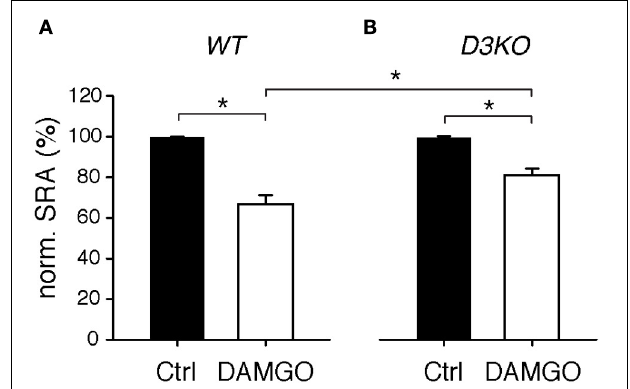
FIGURE 4 | Modulation of spinal reflex amplitudes (SRAs) by the MOR-preferring agonist, DAMGO. (A) In WT, DAMGO induced a significant decrease in SRA (to 66.6 ± 4.5% of control, n = 15). WT: ∗ p < 0 . 001. (B) In D3KO, DAMGO equally significant reduced SRA, albeit to lesser degree than in WT (to 80.9 ± 3.4%, n = 8). D3KO: ∗ p < 0 . 001. The difference between DAMGO-induced effects in WT and D3KO was significant ( p = 0 . 013).